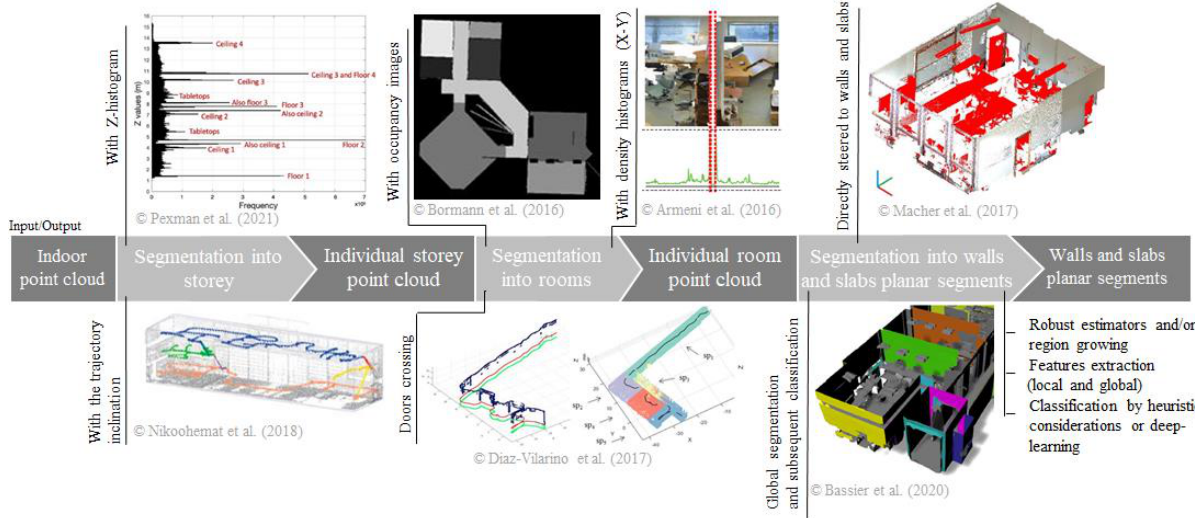
Figure 2. Main segmentation workflow followed by authors in automatic scan-to-BIM